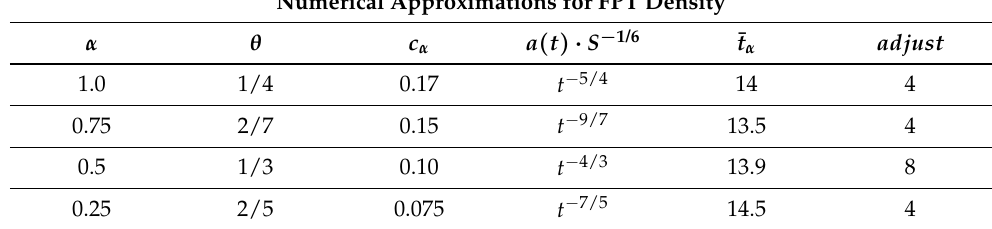
Table 1. For the specified values of fractional order α , the persistence exponent θ , the estimates of c α , the power decaying function a ( t ) · S − 1/6 , the value ¯ t α and the value of the adjust parameter are reported. Note that here, S = 0.1, and the value of c α is evaluated as d ( ¯ t α ) / a ( ¯ t α ) , with d ( t ) the simulated density and a ( t ) is as in (20). The values of adjust are used in the evaluation of the density R-function to obtain the smoothed simulated density d ( t ) . Numerical Approximations for FPT